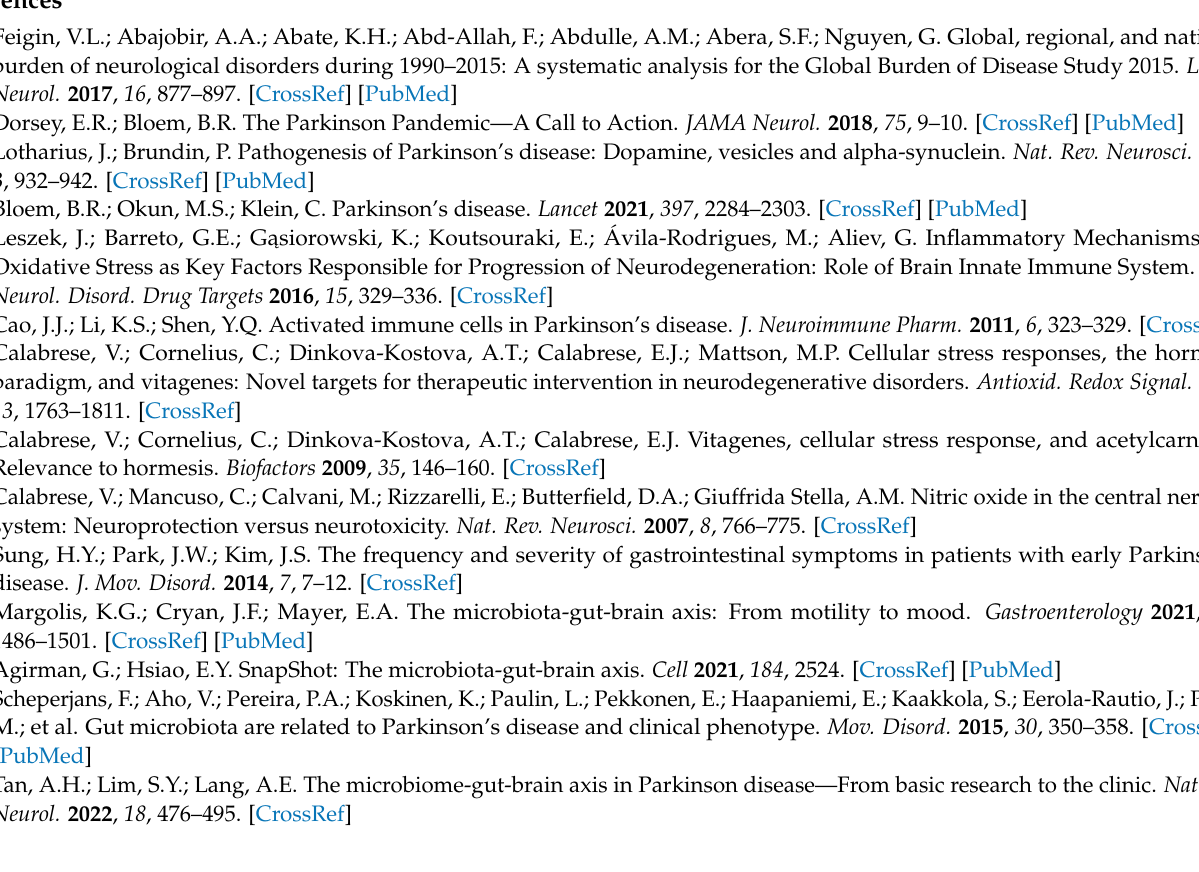
Table S2. Top 30 different fecal metabolites in FC value and P adjusted value between the intervention group of L. plantarum CCFM405 and rotenone-induced PD mice; Table S3. The top 30 different serum metabolites in FC value and P adjusted value between normal mice and rotenone-induced PD mice; Table S4. Top 30 different serum metabolites in FC value and P adjusted value between the interven- tion group of L. plantarum CCFM405 and rotenone-induced PD mice; Table S5. Primers information used for